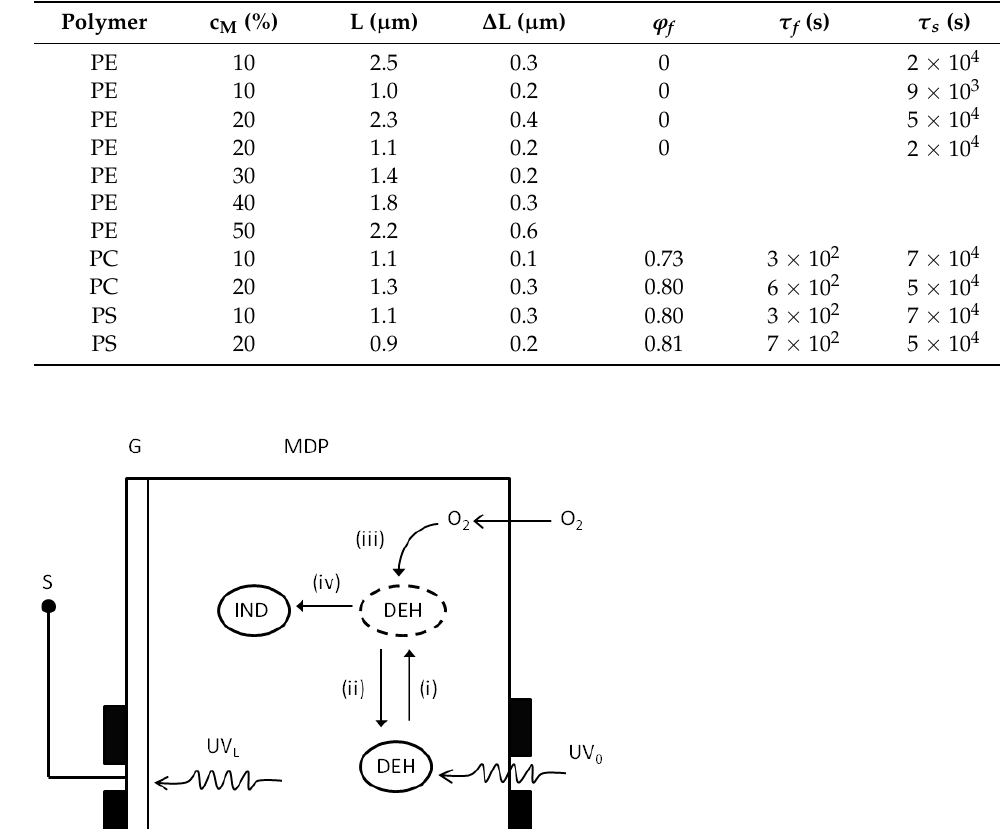
Table 1. Details of the MDP samples used to undertake the spectral and absorbance measurements.